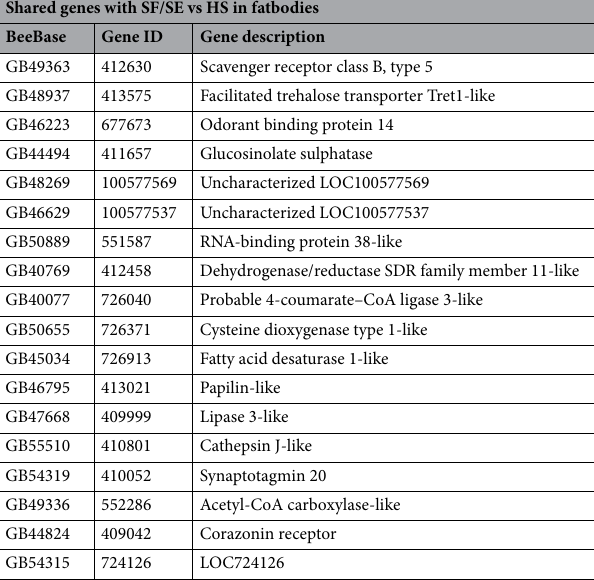
Table 2. DEGs shared between the fat bodies of SF and SE queens vs HS queens (this study) and the brains of mated vs virgin queens (Manfredini et al. 37